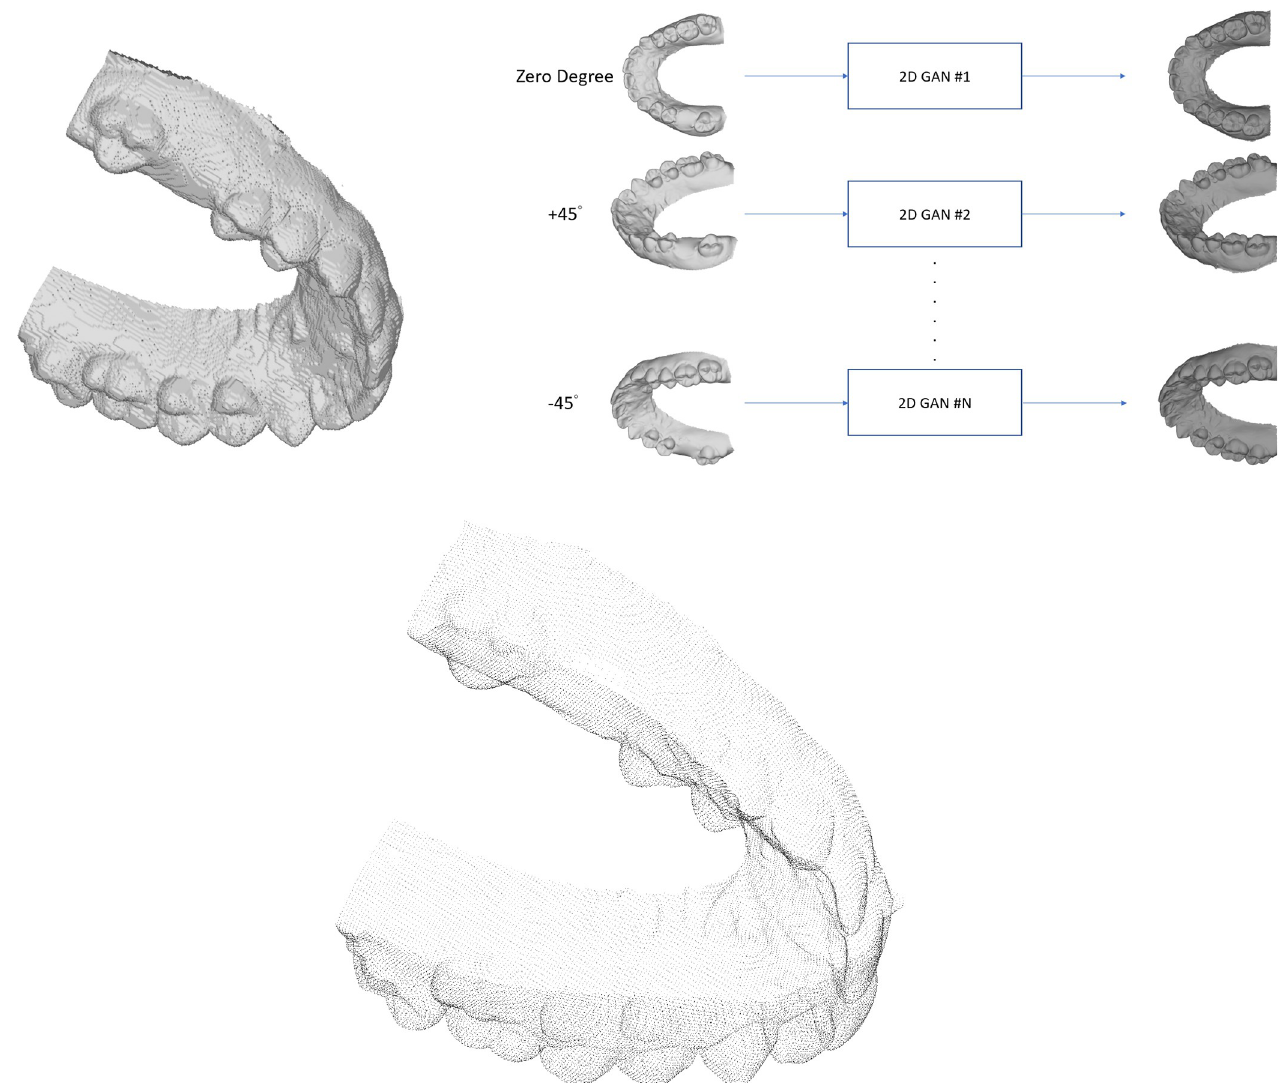
Fig 5. A. Illustration of voxel-based method. B. Illustration of view-based method. C. Illustration of point-based method.